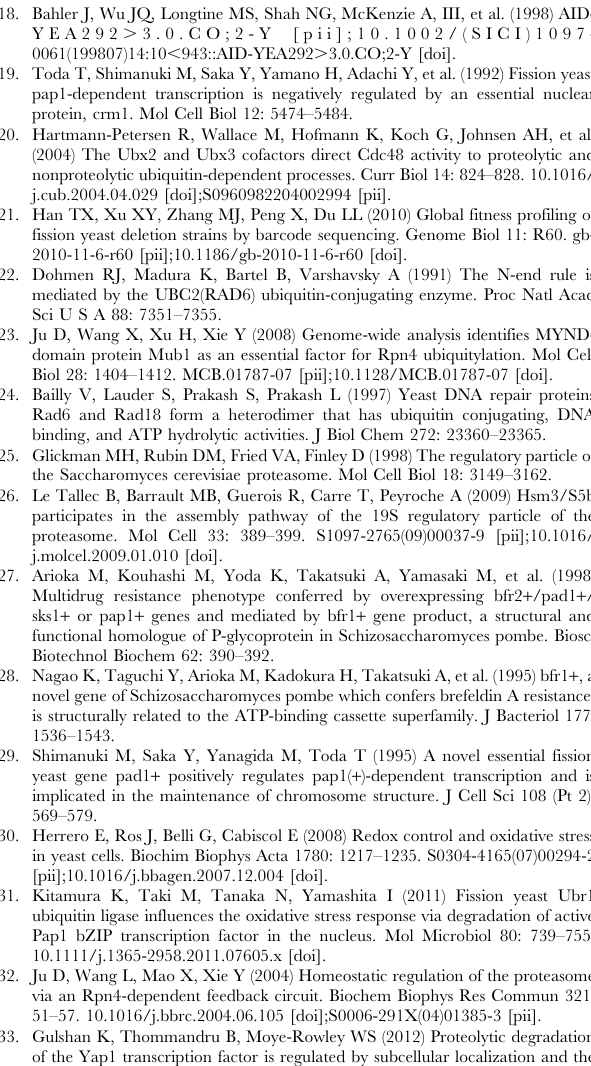
Figure S1 Proteasome levels are unchanged in a pap1 D mutant. Whole cell extracts from wild type (wt) and pap1 D strains were analyzed by SDS-PAGE and Western blotting using antibodies to the 26S proteasome subunit Rpn1/Mts4 and 20S a subunits. Antibodies to tubulin were used to ensure an even loading. No significant differences between the strains in proteasome levels were